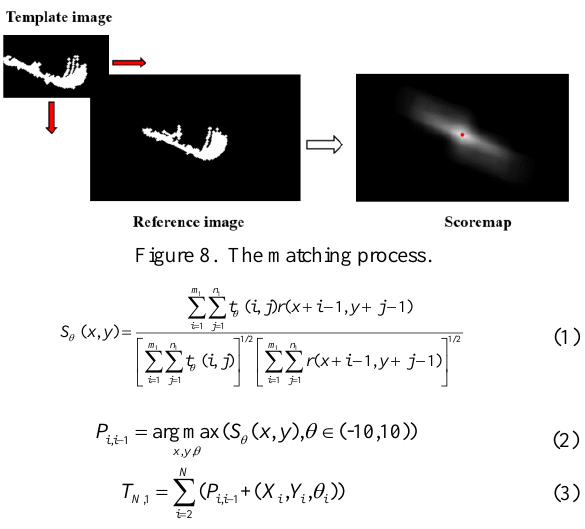
Figure 6. Conversion from 3D points to two 2D images.